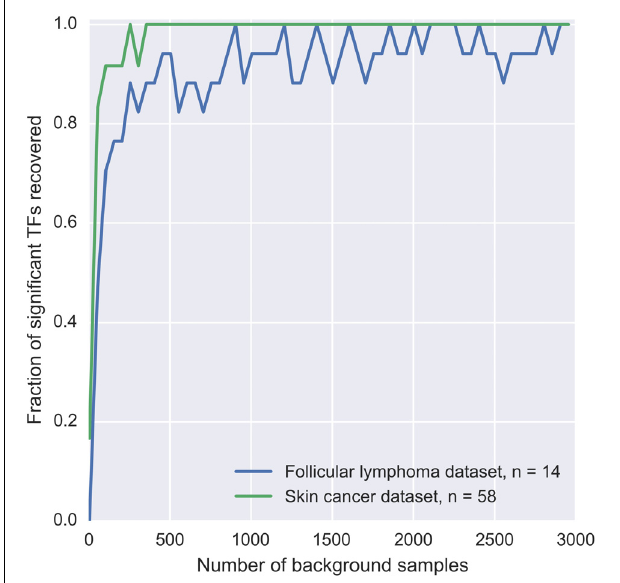
FIGURE 2 | Estimation of sufficient background samples for BayesPI-BAR2 package. The plot displays the dependency of significant TF discovery on the number of background samples used. Significant TFs in the mutation blocks from two different datasets are considered: (1) two BCL2 blocks from FL dataset with 14 patients affected, blue line; (2) and the TERT block from skin cancer dataset with 58 patients affected, green line. On the X -axis, we plot the number of background mutation blocks taken. On the Y -axis, we plot the number of significant TFs found when using X background mutation blocks, which are also significant when using the full set of 10000 background blocks. Y is normalized by the number of significant TFs discovered using the full background set. Therefore, Y = 1 corresponds to the same result as using the full background